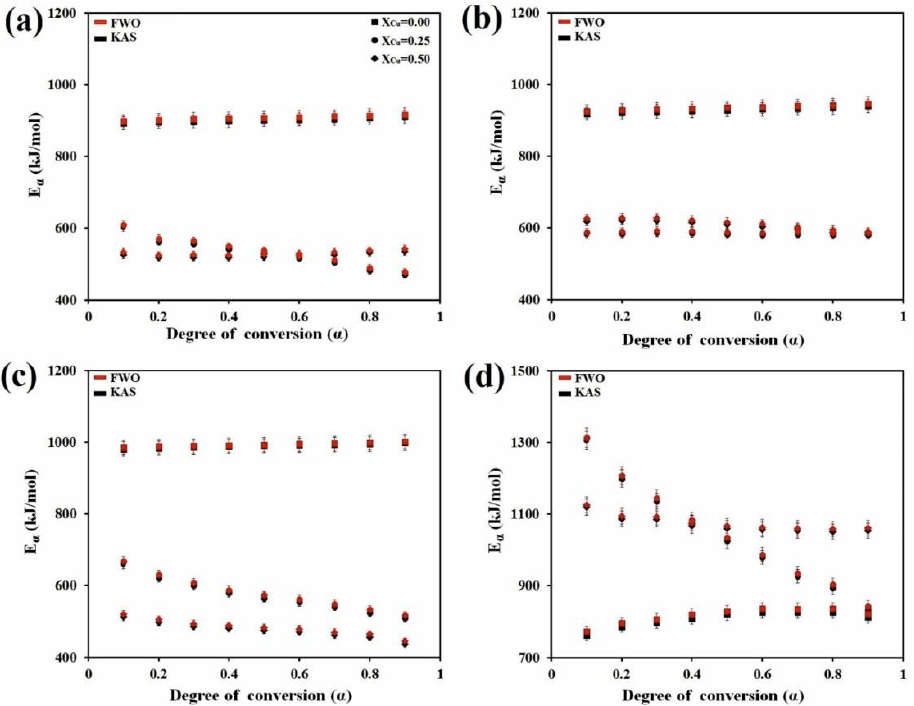
Figure 3. Dependence of E α on α examined for (Fe 41 Co 7 Cr 15 Mo 14 Y 2 C 15 B 6 ) 100 − x Cu x (x = 0, 0.25 and 0.5 at.%) by using Kissinger–Akahira–Sunose (KAS) and Flynn–Wall–Ozawa (FWO) methods for peak ( a ) I, ( b ) II, ( c ) III and ( d )